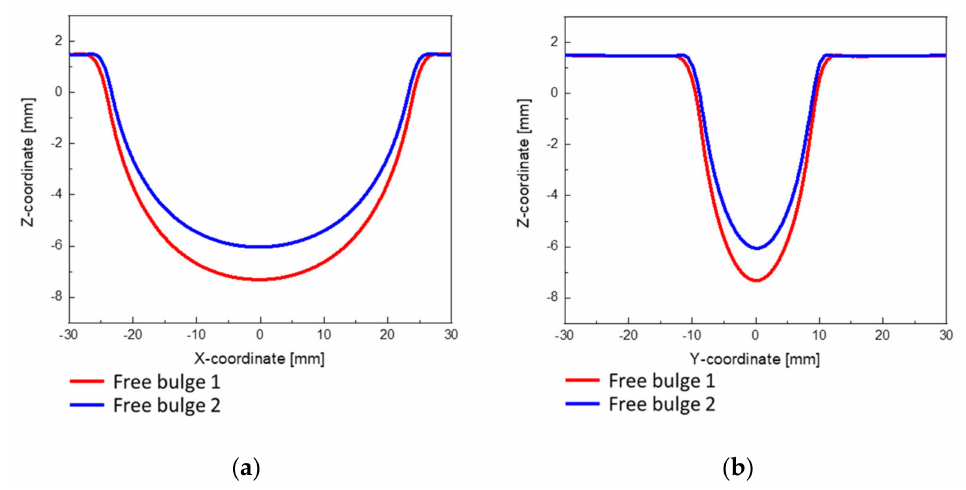
Table 8. Cross-section and sheet inflow of free bulge models for EMF.